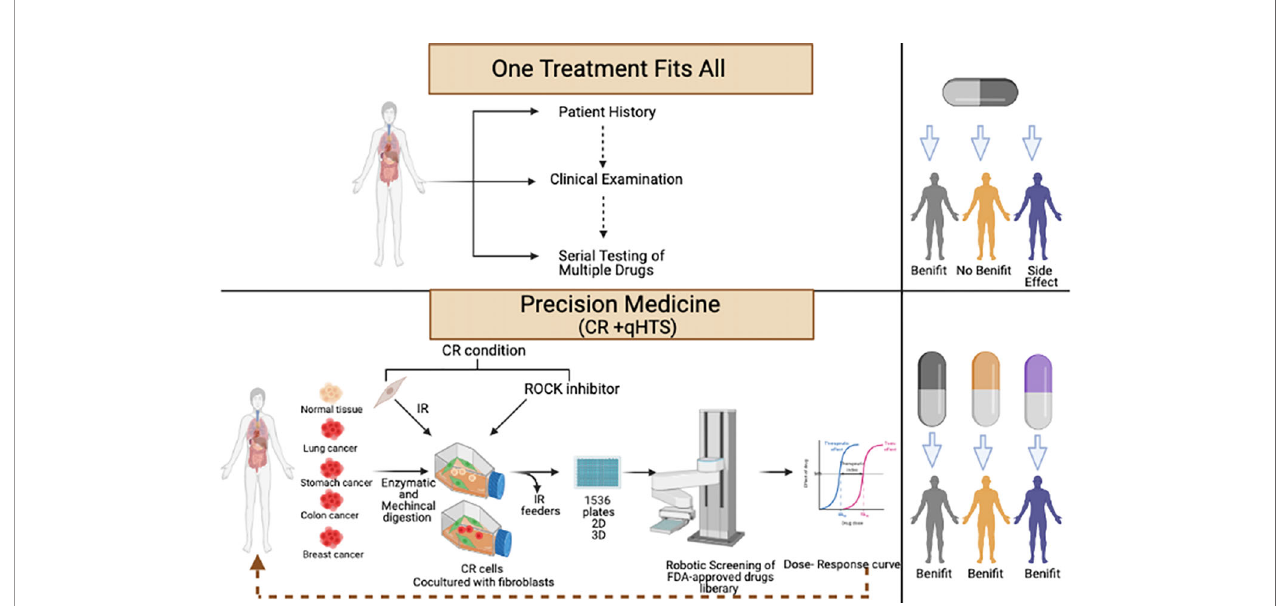
FIGURE 2 | Work fl ow of conditional reprogramming (CR) technology and robotic quantitative high-throughput screening (qHTS) for precision